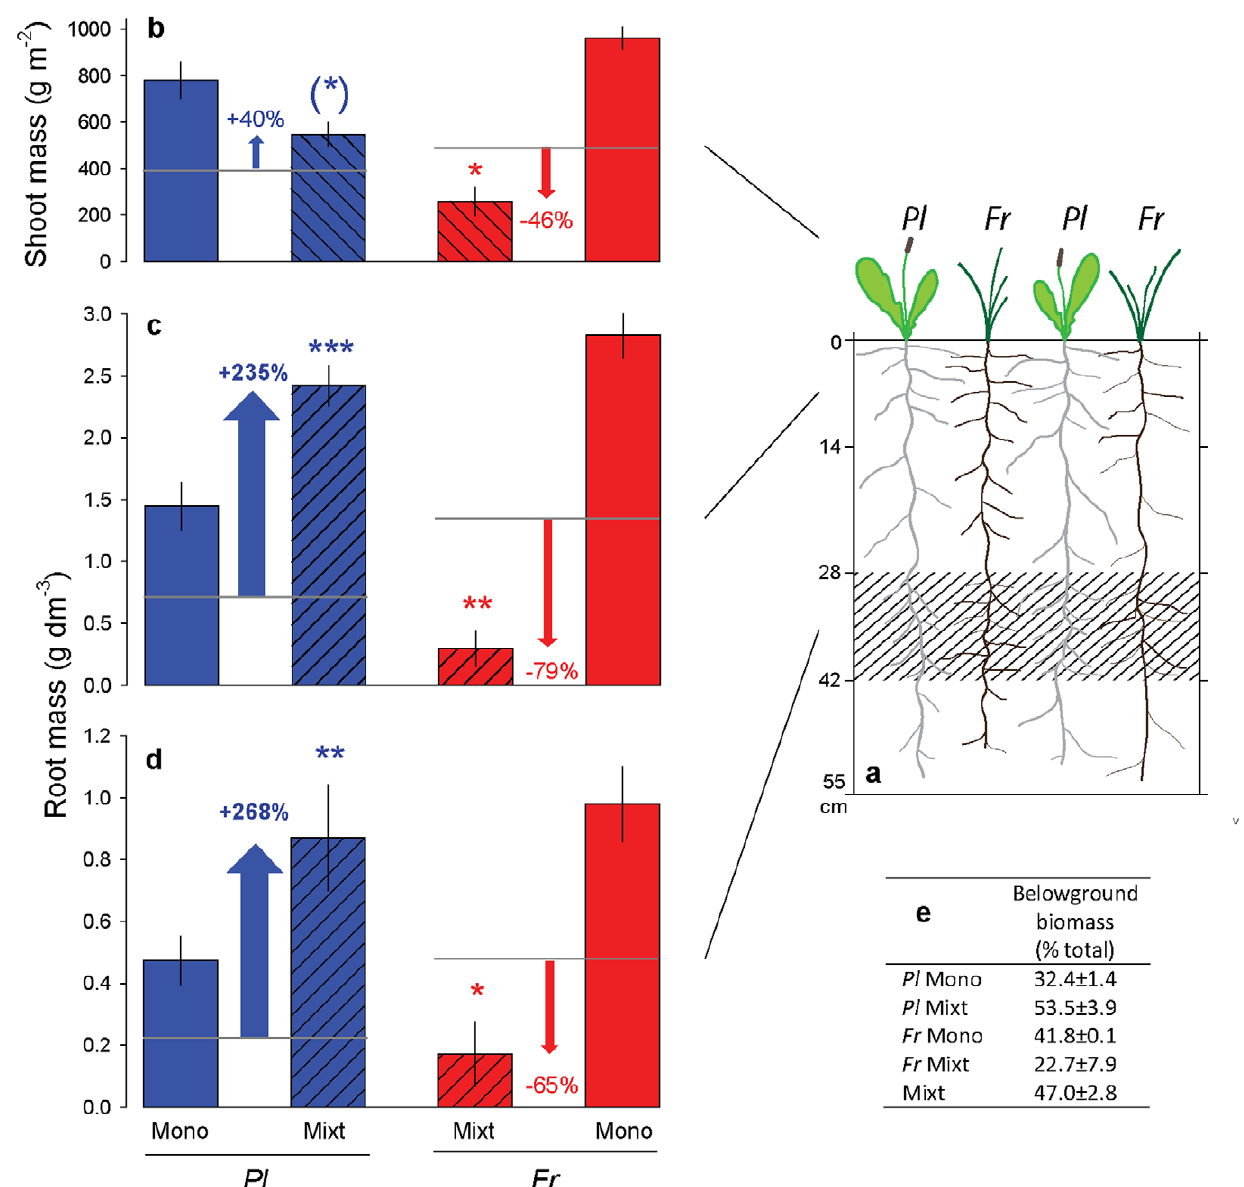
Figure 1. Experimental setup and biomass data. Planting scheme ( a ); shoot ( b ) and root mass in the poor top ( c ) and rich bottom layer ( d ); percentage belowground biomass at harvest ( e ), in Festuca rubra ( Fr ) and Plantago lanceolata ( Pl ) monocultures and mixtures. Horizontal lines in b–d show expected values for mixtures in case of competitive-equivalence (i.e., 50% of monocultures, or a relative yield of 0.5), and arrows depict the percentage deviation. Asterisks show significant differences between observed and expected values after t-tests. Data are means 6 SE, N=3–4. (*) P , 0.06; * P , 0.05; ** P , 0.01; *** P , 0.001.